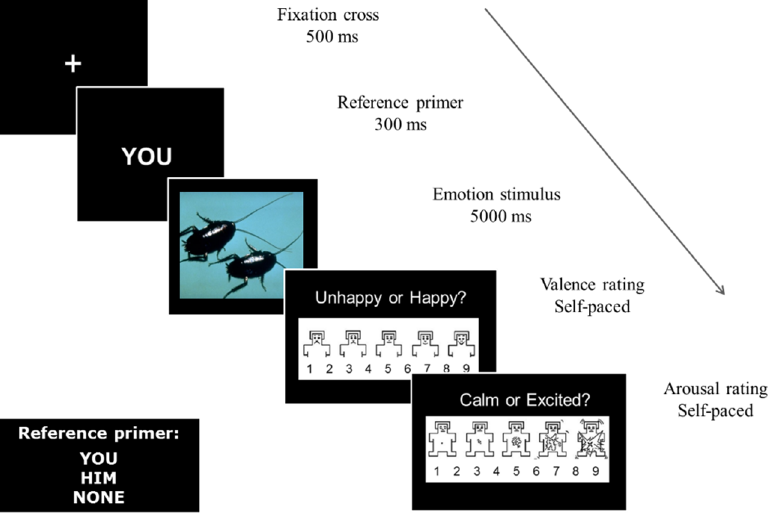
Figure 1. Trial sequence of events. In addition, a 200 ms inter-stimulus interval consisting of a black screen was displayed between each trial event.